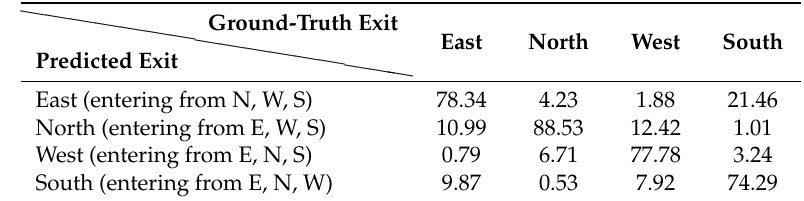
Figure 12. Aggregate results for roundabout dataset using decision trees. The figure shows (colour-coded for each of the 12 test categories) the locations of the points beyond which 100% correct intention estimation was achieved for each test trajectory (plotted as coloured dots). The figure also shows (for each of the 12 test categories) the location of grid cell closest to the mean location of the points belonging to that category beyond which 100% correct intention estimation was achieved. Table 2. Confusion matrix for predicted vs. ground-truth exits, using decision-tree method for intention